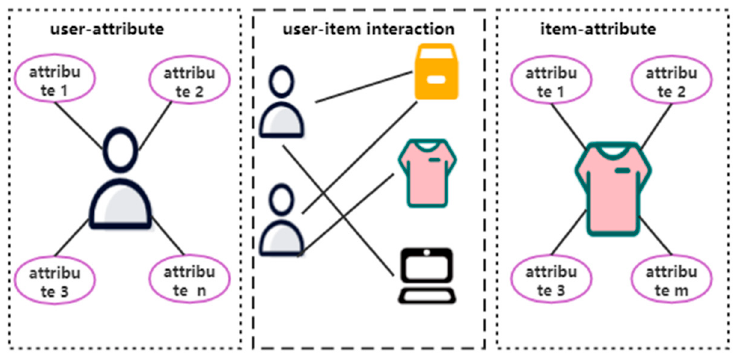
Figure 1. Graph Data contains the user–item graph and the user–attribute graph, and the item– attribute graph.